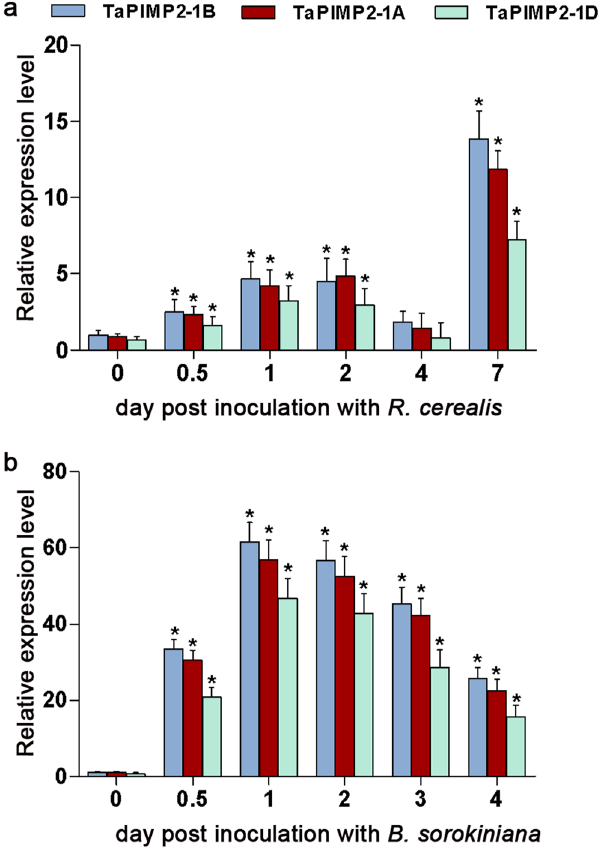
Figure 3. Transcriptional patterns of TaPIMP 2 homoeologous member response to fungal infection. Transcription of TaPIMP 2 homoeologous member response to infection with Rhizoctonia cerealis in in wheat line CI12633 ( a ) and infection with Bipolaris sorokiniana in wheat cultivar Yangmai 6 ( b ) was examined by RT-qPCR. The samples were collected from stem of infected wheat plants. The relative gene expression was quantified using the comparative threshold (2 −ΔΔ CT ) method. The transcriptional level of TaPIMP2 - 1B from the untreated wheat plants was used as control. The mean and standard deviation were calculated using data from three independent biological replicates. Asterisks indicate statistically significant differences. (Student’s t - test : * P <